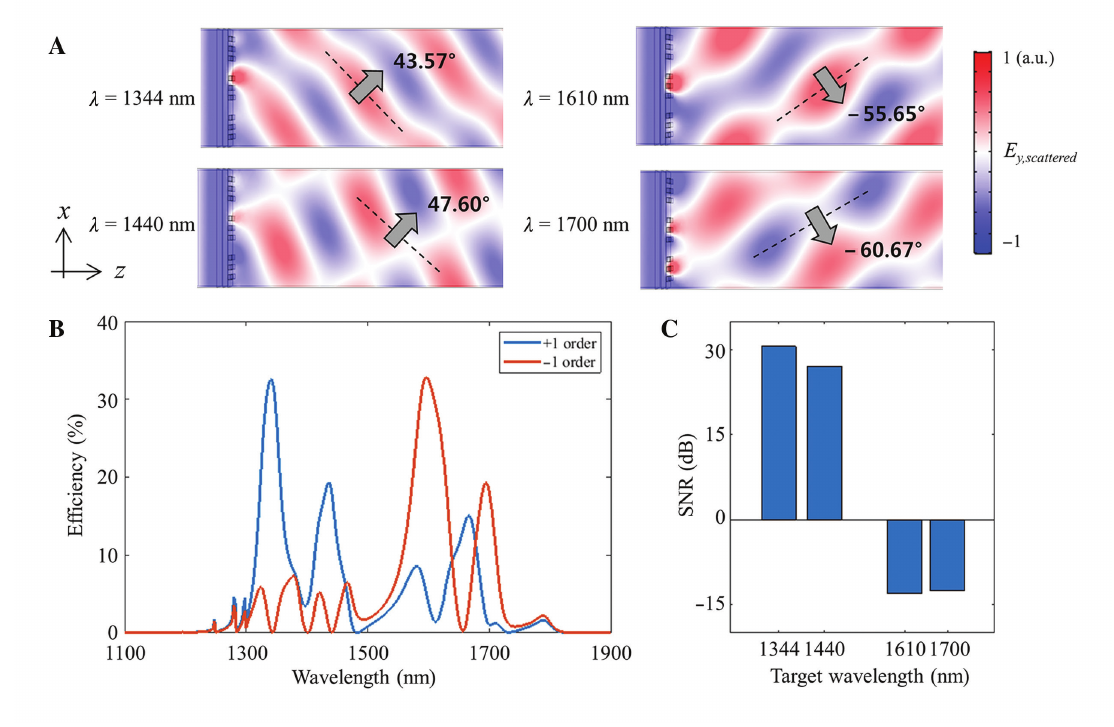
Figure 3: Numerical results for the performance of the proposed metasurface. (A) Scattered electric field distributions ( E ) of reflected light for four target wavelengths 1344, 1440, 1610, and 1700 nm. Each arrow and y dotted line indicate deflection direction and wavefront with angle information, respectively. (B) Diffraction efficiency for the + and - first- order directions in the case of broadband source illumination. (C) SNR at each target